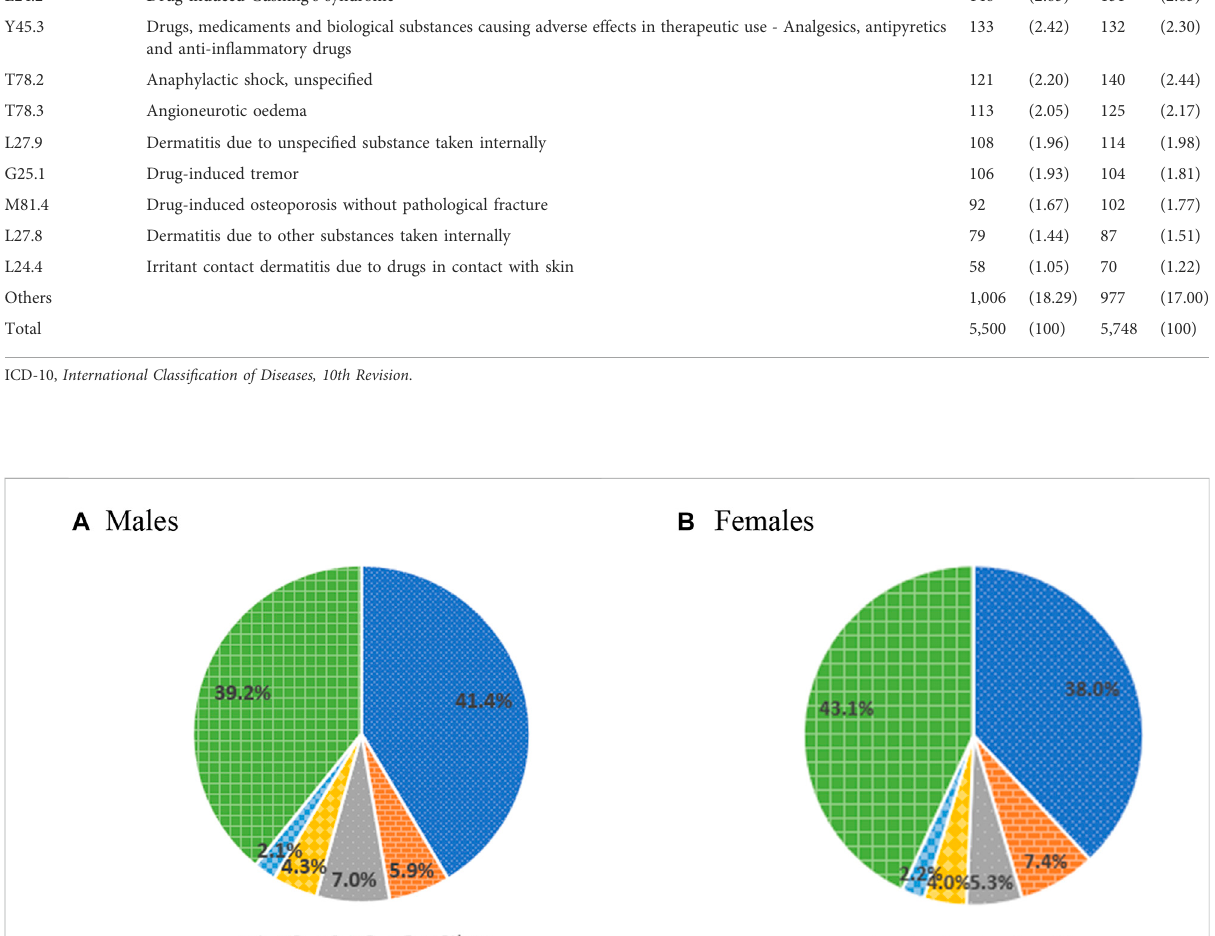
Figure 1). In contrast, in the over-80 age group, a higher prevalence of ADEs was observed in males compared with females. In addition, in both men and women, the prevalence